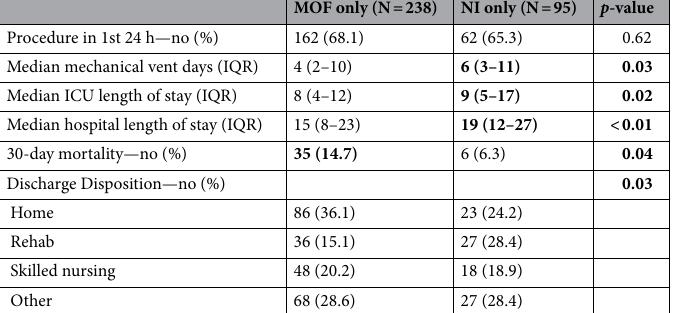
Table 5. Additive hospital resource utilization of MOF and NI. Significant values are in